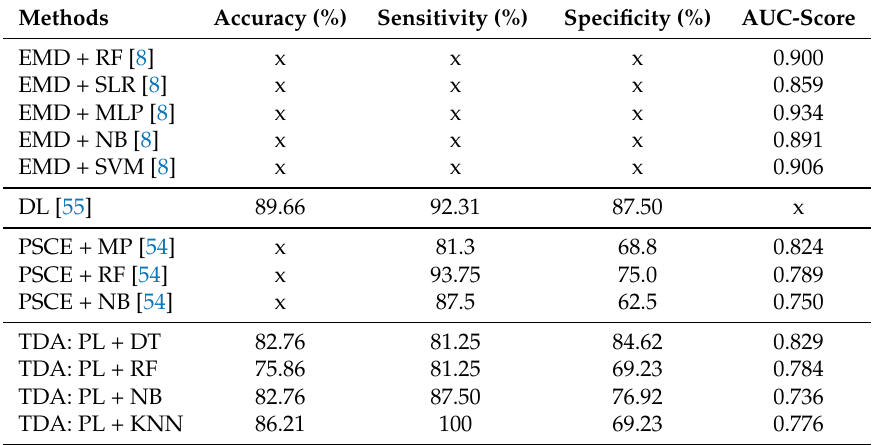
Table 6. Comparisons of AUC and leave-one-out cross-validation (LOO-CV) Results for classification of HC and ALS